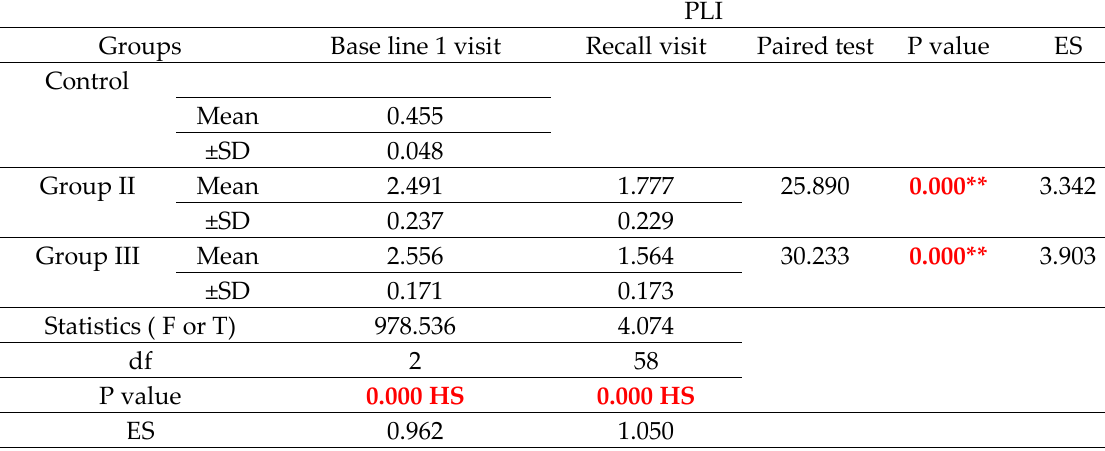
Table 1: Intra- and Inter-comparisons of PLI among groups and visits using one way Analysis of Variance ANOVA, Paired sample t-test and Independent Sample t-test.